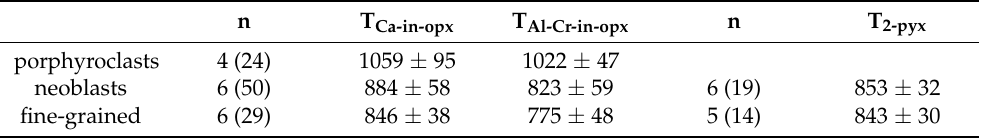
Figure 12. ( a ) Cr 2 O 3 (wt.%) vs. Al 2 O 3 (wt.%) in opx; ( b ) CaO vs. Al 2 O 3 in opx; ( c ) Cr 2 O 3 (wt.%) vs. Al 2 O 3 (wt.%) in cpx; ( d ) TiO 2 (wt.%) vs. Al 2 O 3 (wt.%) in cpx. Red symbols are porphyroclast, orange symbols are neoblasts and yellow symbols are grains in fine-grained layers. Table 2. Results of geothermometry calculations for porphyroclasts, neoblasts and neoblasts in fine-grained layers. “n” indicates how many porphyroclasts or different areas in the thin section were measured and in brackets the total number of measurements is given. The temperatures are the averages in °C with their standard deviation.